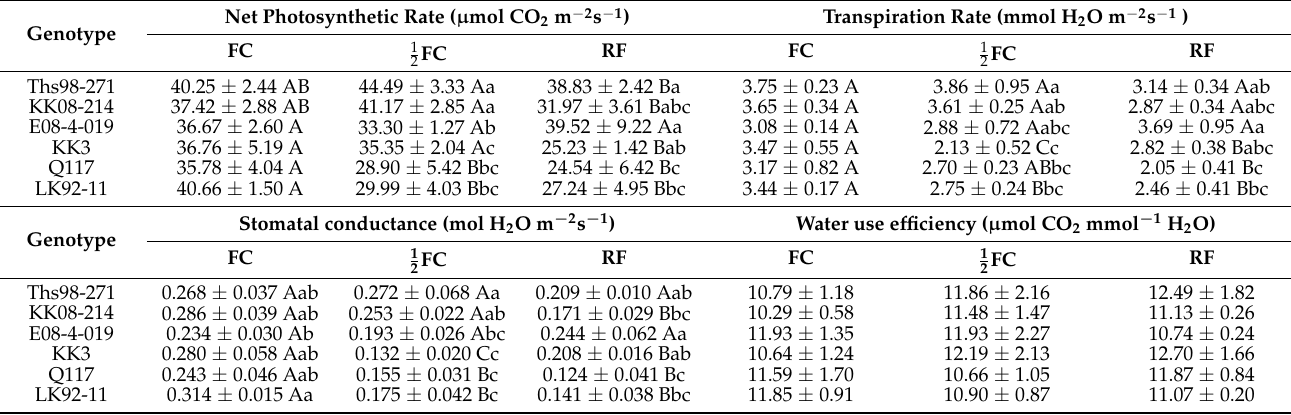
FC = field capacity, 1 FC = 1 field capacity and RF = rain fed. Different uppercase letters indicate significant differences among irrigation 2 2 treatments in each genotype; different lowercase letters indicate significant differences among genotypes in each irrigation treatment by LSD at p ≤